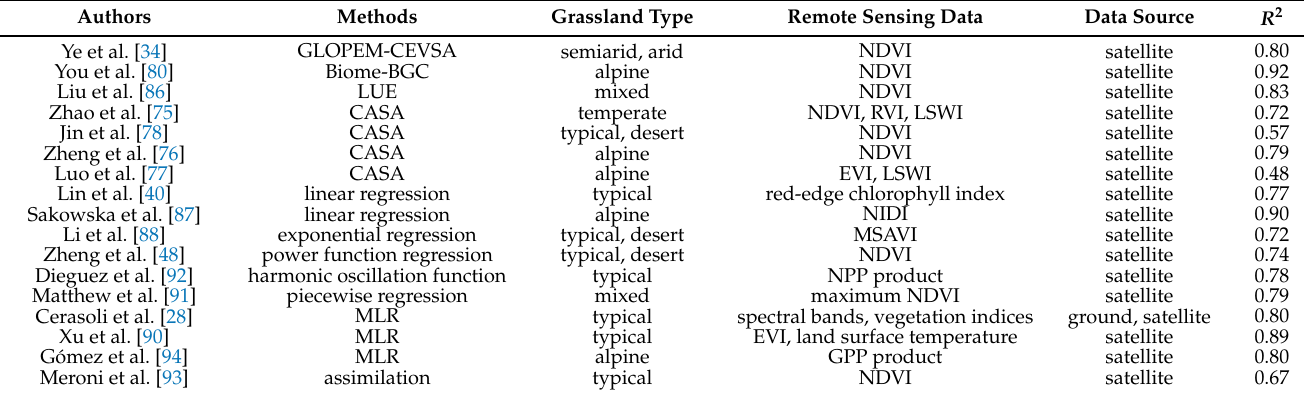
Table 3. Detailed information on the involved estimation studies for primary